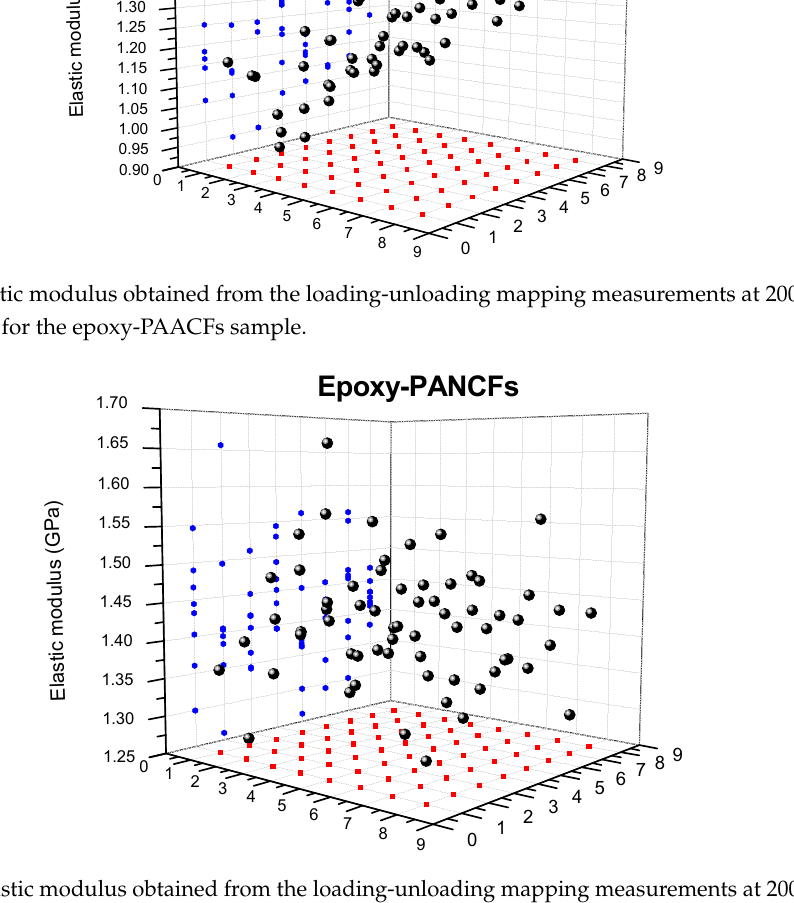
Figure 10. Elastic modulus obtained from the loading-unloading mapping measurements at 200 nm of displacement for the epoxy-PANCFs sample.